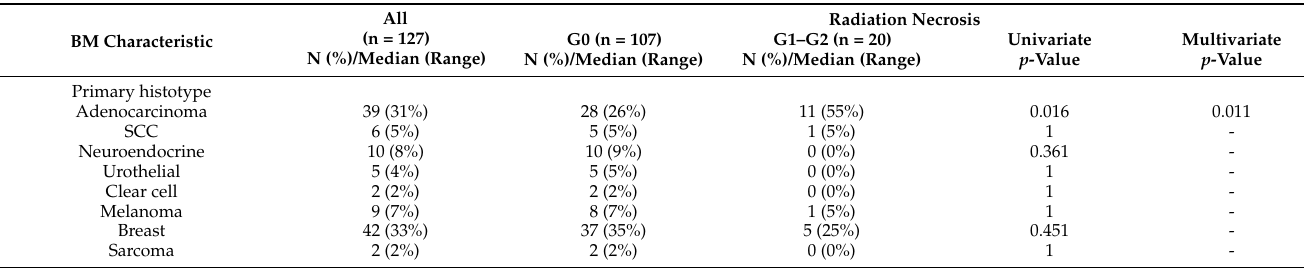
Table 2. Clinical and treatment characteristics for all BMs and for BMs grouped according to any- grade RN development or not.